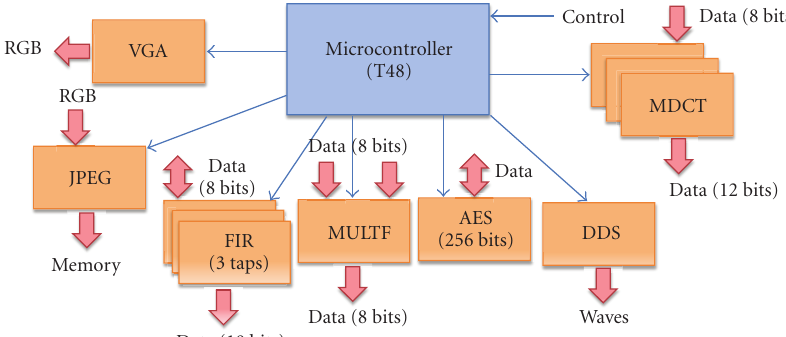
Figure 6: Hardware tasks of the application.